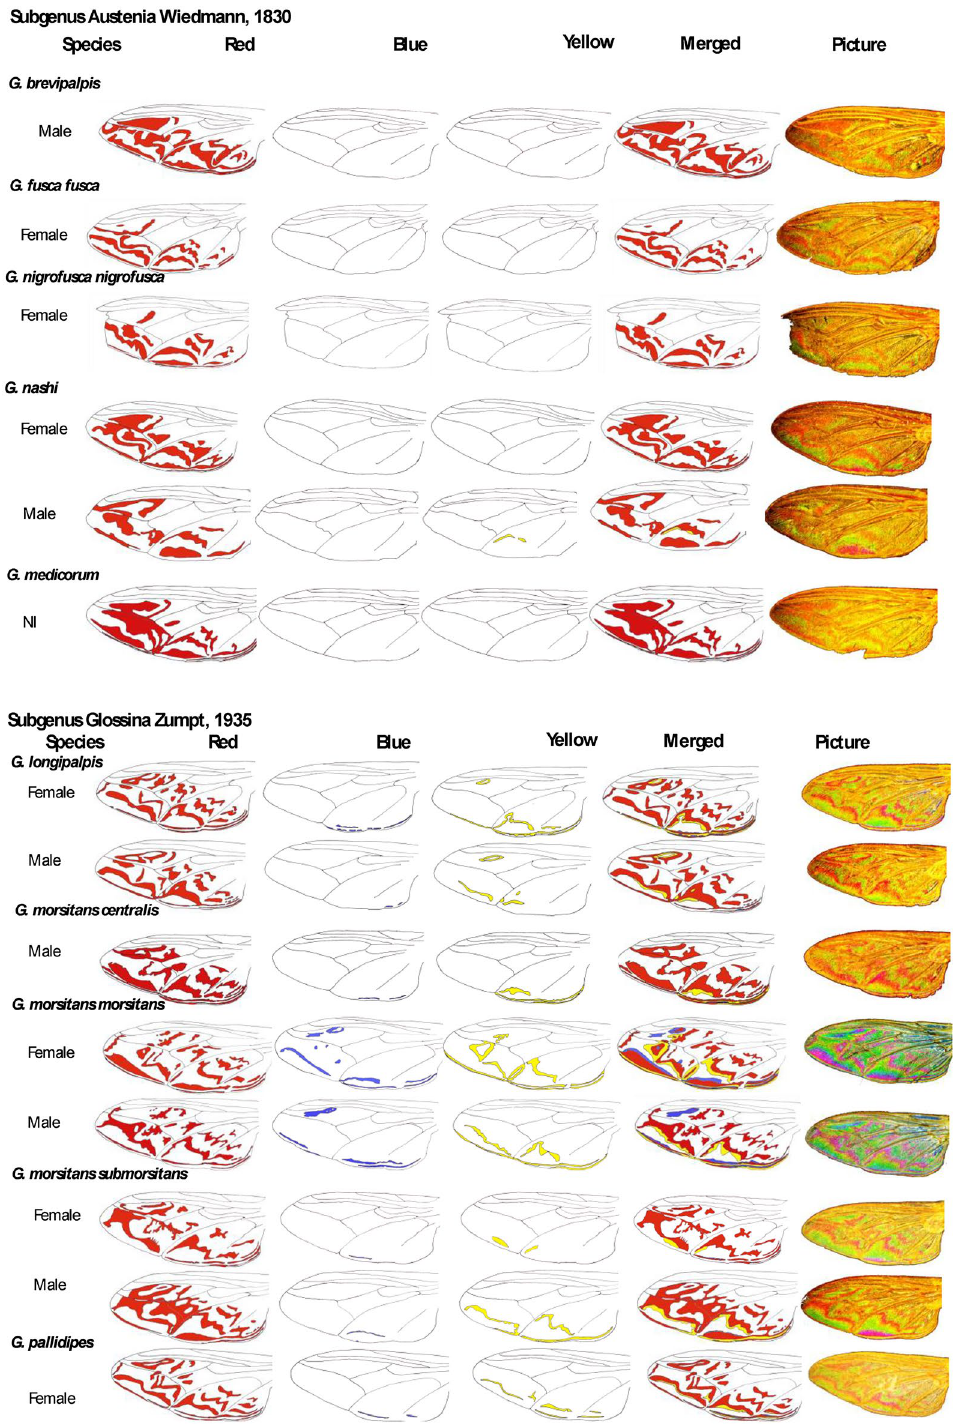
Figure 6. Selected Glossina spp pictorial key, deduced from Wing Interferential